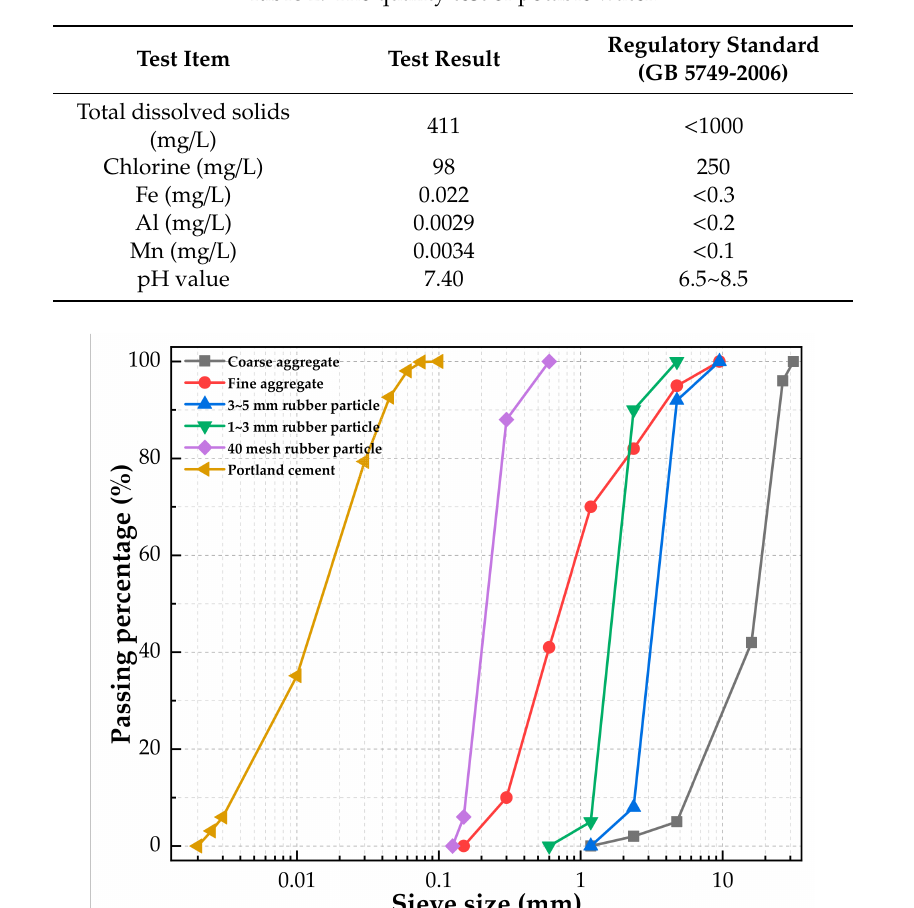
Table 2. The quality test of potable water.